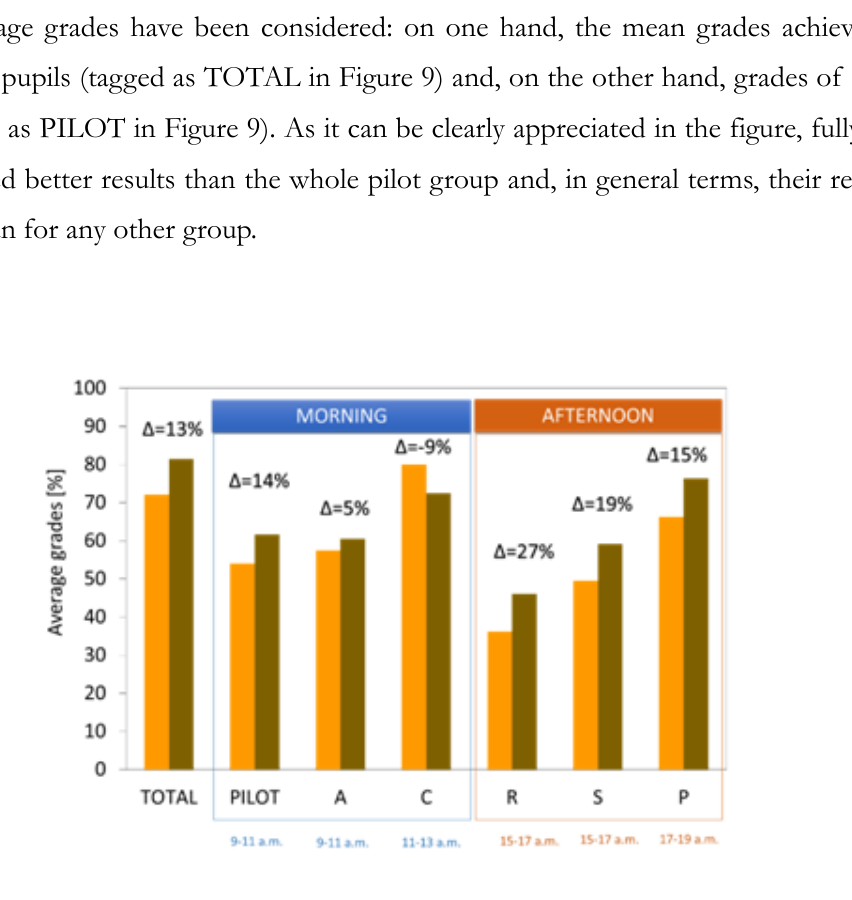
Figure 9. Average grades for tasks and final examination for every group as a function of the class